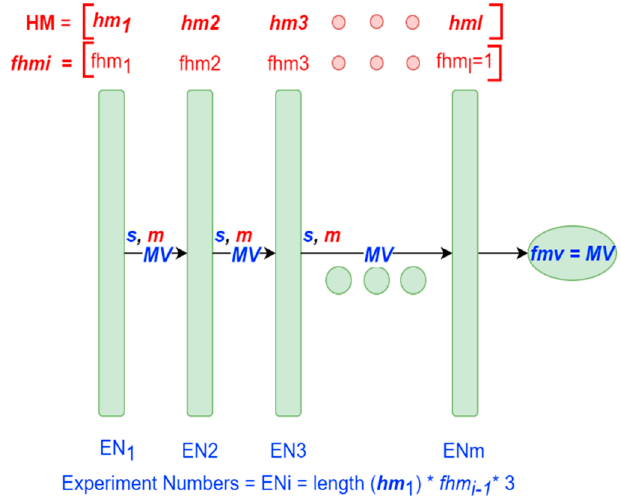
Figure 4. Graph procedure of the proposed tuning methodology.